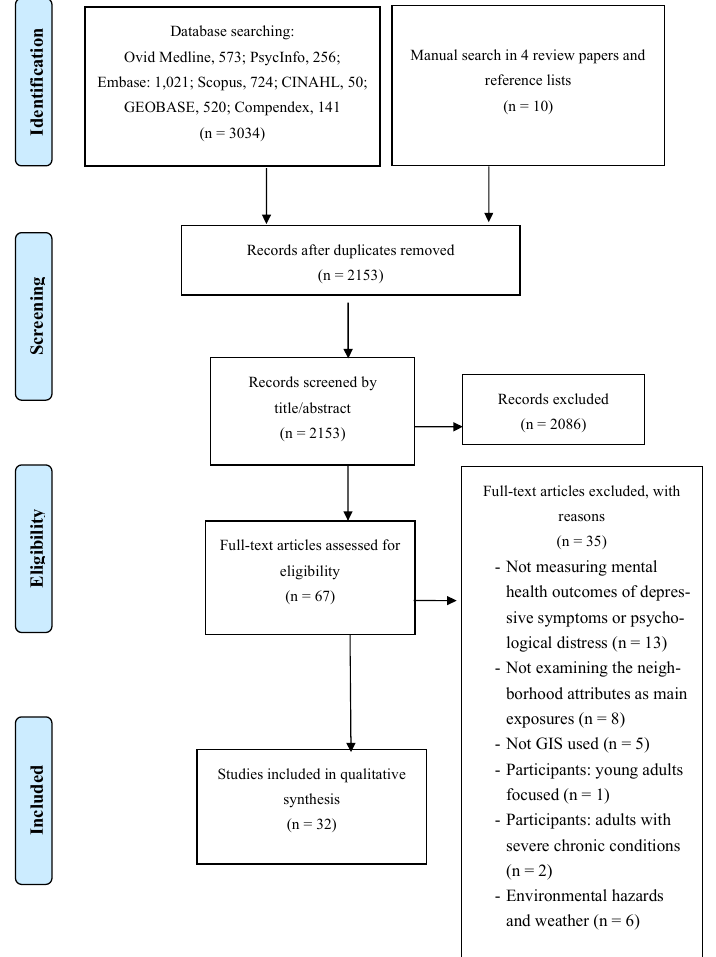
Figure 1. Flow chart on study selection process.